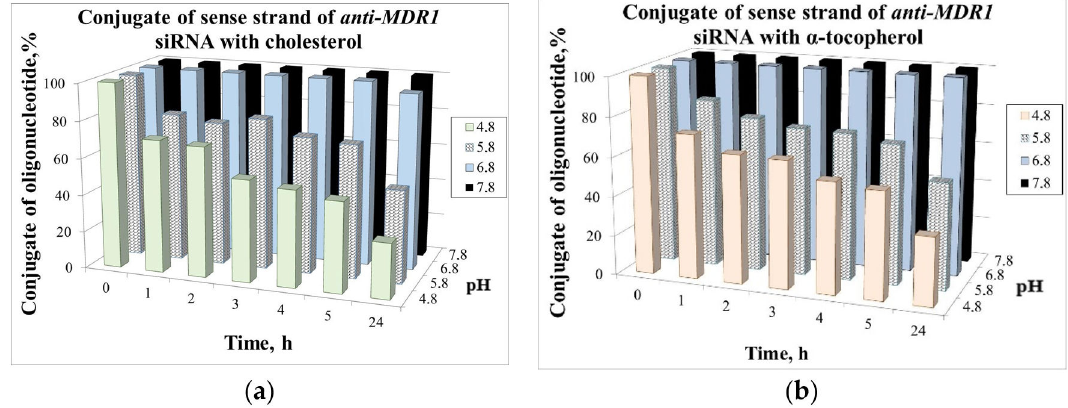
Figure 5. Hydrazone bond hydrolysis in Chol- L -siRNA/s ( a ) and Toc- L -siRNA/s ( b ) conjugates: quantification of the full-size conjugate (%, axis Y) depending on pH and the time of